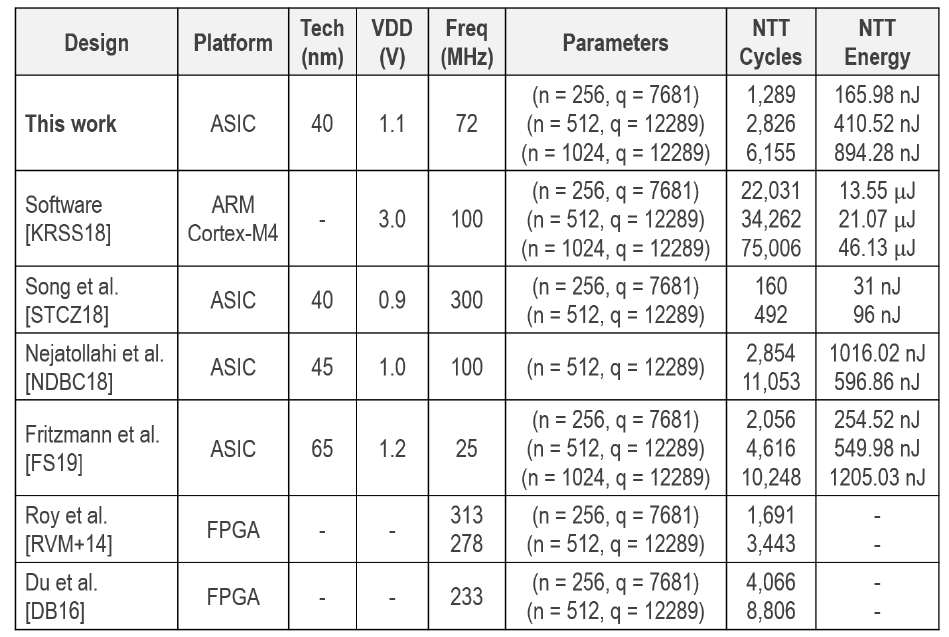
Table 1: Comparison of our NTT performance with